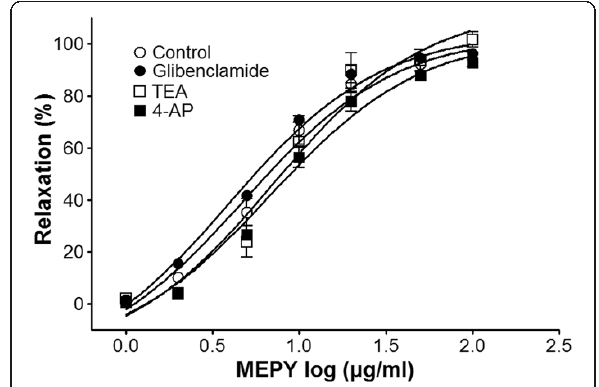
Figure 4 Relaxation responses induced by MEPY in endothelium-intact rat aortic rings pre-contracted with phenylephrine (PE, 1 μ M) in the presence or absence (control) of glibenclamide (10 μ M), tetraethylammonium (TEA, 5 mM), or 4-aminopyridine (4-AP, 1 mM) in Krebs-Henseleit solution. The relaxant effects of MEPY on isolated rat aortic rings were calculated as a percentage of the contraction in response to PE. Values are expressed as mean ± SEM (n = 6 – 8).